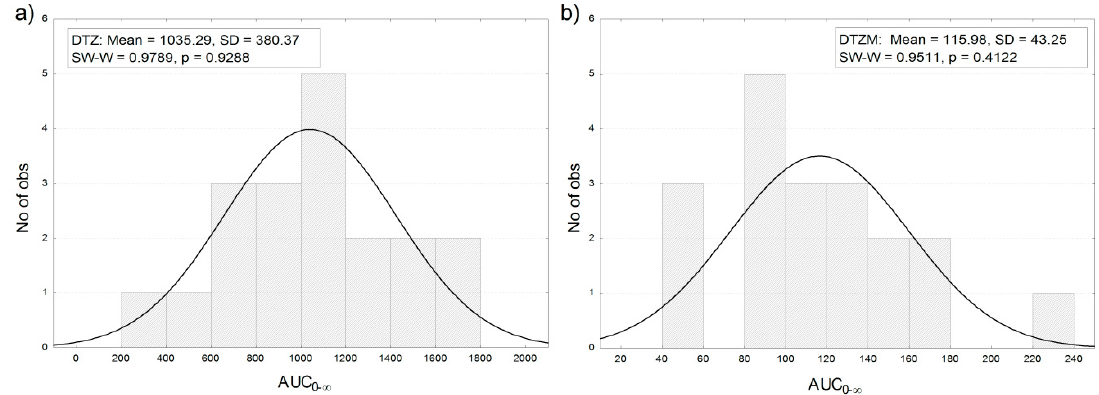
Figure 4. Frequency distribution of AUC 0– ∞ for ( a ) DTZ and ( b ) DTZM after the oral administration of 120 mg of DTZ in 19 healthy subjects (the observed significance level p of the Shapiro–Wilk statistic W (SW–W) indicates normality of the distribution ( p < 0.05)).